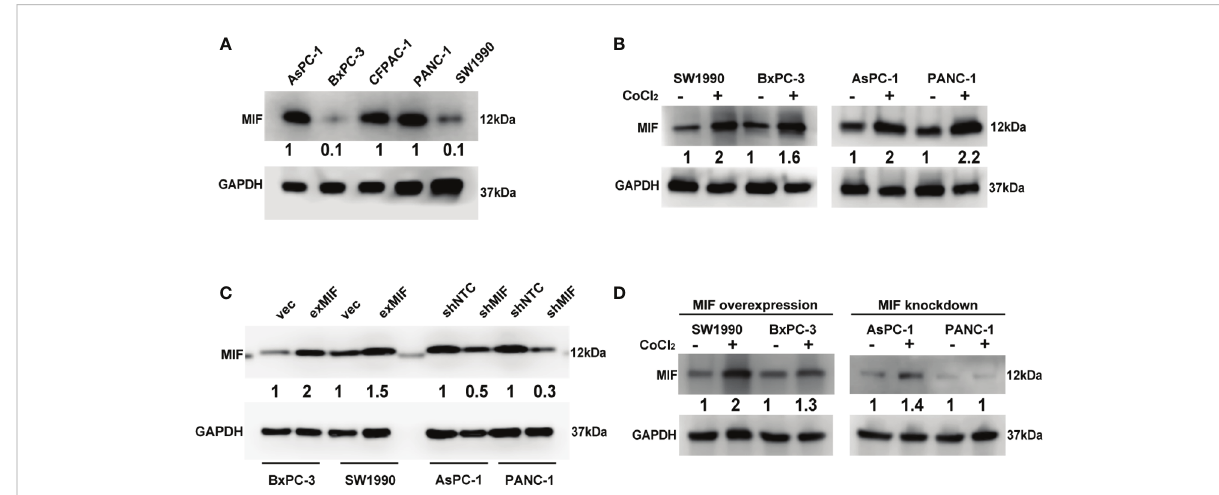
FIGURE 3 Detection of MIF expression in PDAC cell lines Western blot analysis of MIF protein levels in fi ve human PDAC cell lines (A) , MIF expression after CoCl 2 treatment for 24 h compared with vehicle (B) , transduction ef fi ciency of lentivirus-cDNA-MIF (exMIF) or vector (vec) for MIF overexpression and lentivirus-shRNA (shMIF) or nontarget control (shNTC) for MIF knockdown (C) , and MIF expression after CoCl 2 treatment in stably transduced cells (D) . The loading control was assessed by GAPDH blotting. The numbers below the blots are quantitative ratios of the MIF/GAPDH band densities. CoCl 2 concentration used: SW1990, 150 m M; BxPC-3, 200 m M; AsPC-1, 150 m M; PANC-1, 300 m